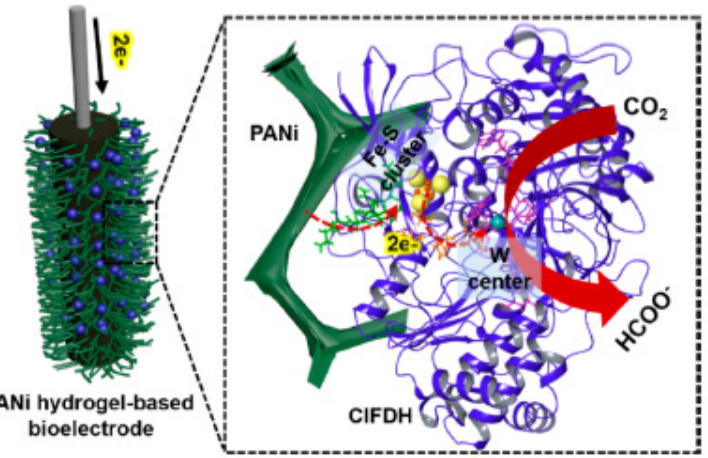
Figure 9. Schematic Illustration of ClFDH -PANi Electrode and Direct Electron Transfer from Con- ductive PANi Hydrogel to ClFDH for Electroenzymatic CO 2 Conversion to Formate. Reprinted with permission from Ref [96]. Copyright © 2022 American Chemical Society.